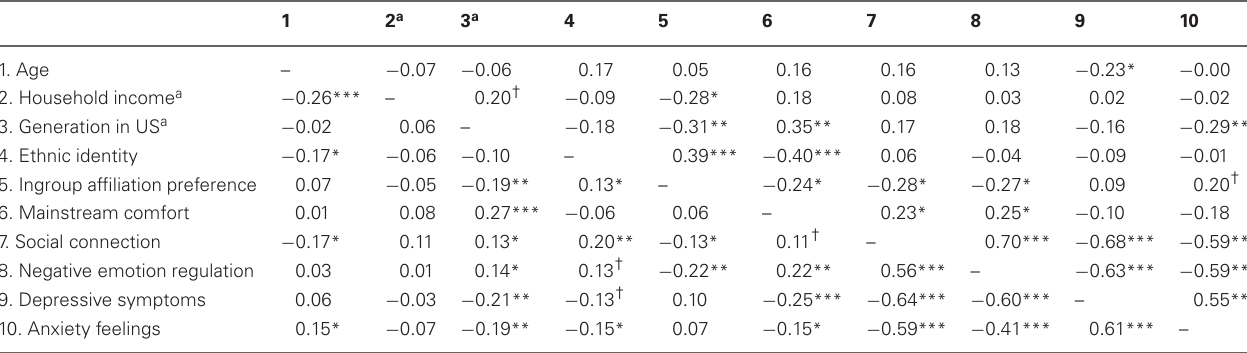
Table 3 | Pearson or Spearman correlations among study variables for non-Hispanic White/European American (Lower Triangle) and for Mexican/Mexican American (Upper Triangle)